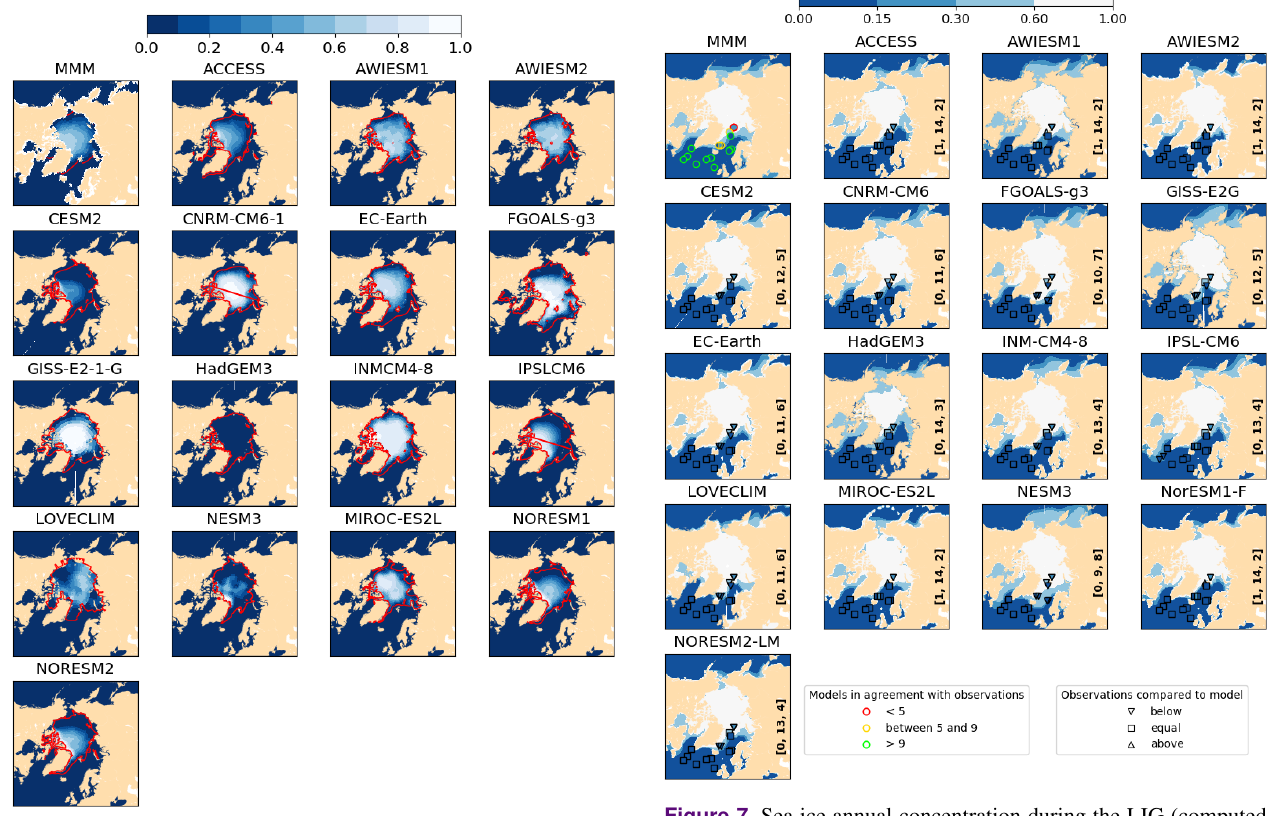
Figure 6. LIG sea ice concentration for the month of minimum SIA (computed with calendar adjustment) as computed for Fig. 2. The magenta contour shows the 0.15 isocontour of the corresponding PI simulation.